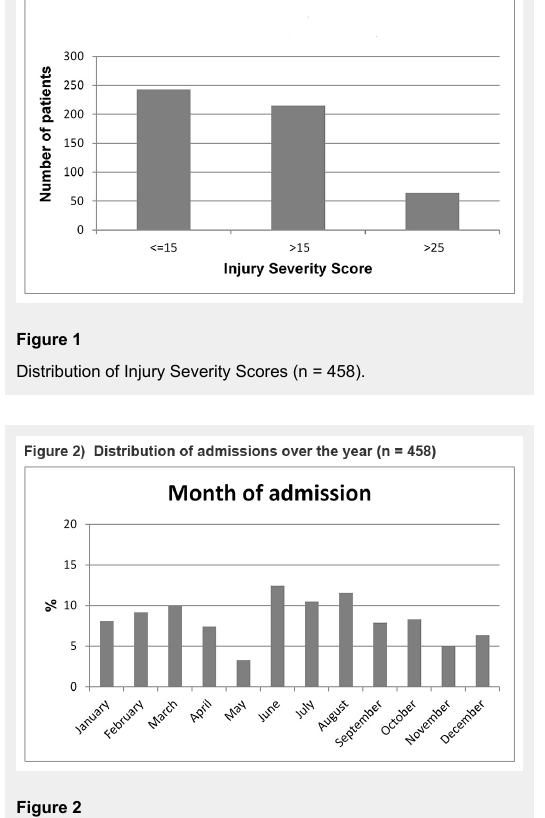
Distribution of admissions over the year (n =